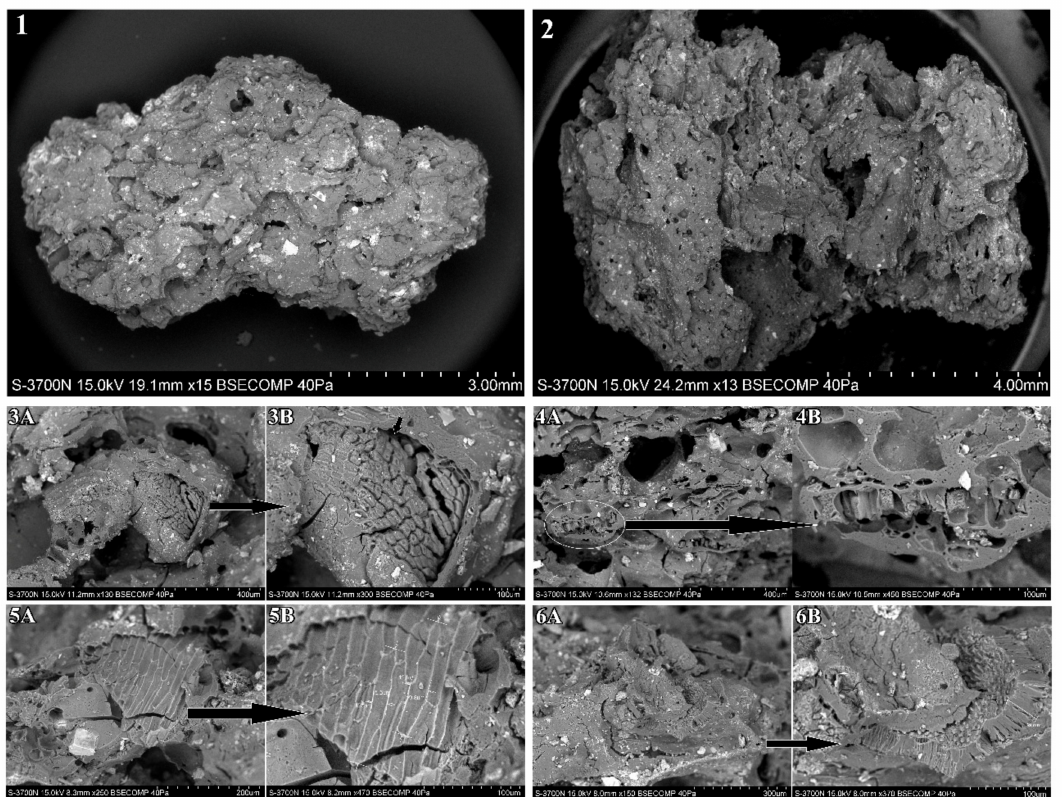
Figure 7. Several SEM micrographs of food fragments from SB: ( 1 ) porridge-like fragment from s.u. 130 made with coarse plant flour; ( 2 ) bread-like fragment from s.u. 125 made with fine plant flour; ( 3A ) SEM micrograph showing fragment of cereal grain embedded in the food matrix; ( 3B ) detail of cereal fragment with visible cross-section of epidermis layers (bran and aleurone layers); ( 4A ) SEM micrograph showing fragments of aleurone layers embedded in the food matrix; ( 4B ) detail of aleurone layer fragment showing the typical rectangular and elongated shape and arrangement of rye/oats aleurone cells; ( 5A ) SEM micrograph showing a fragment of cereal bran embedded in the food matrix; ( 5B ) detail of bran fragment with visible wheat transverse cells, which differ from those of rye and oats in their elongated shape and prolonged, pointy ends; ( 6A ) SEM micrograph showing fragment of legume seed embedded in the food matrix; ( 6B ) detail of legume seed with visible hourglass and palisade layer, which measured approximately 30–50 µ m in thickness. This is consistent with measurements ranging from 20–70 µ m for small pulses such as lentil ( Lens culinaris ) or vetch ( Vicia sativa